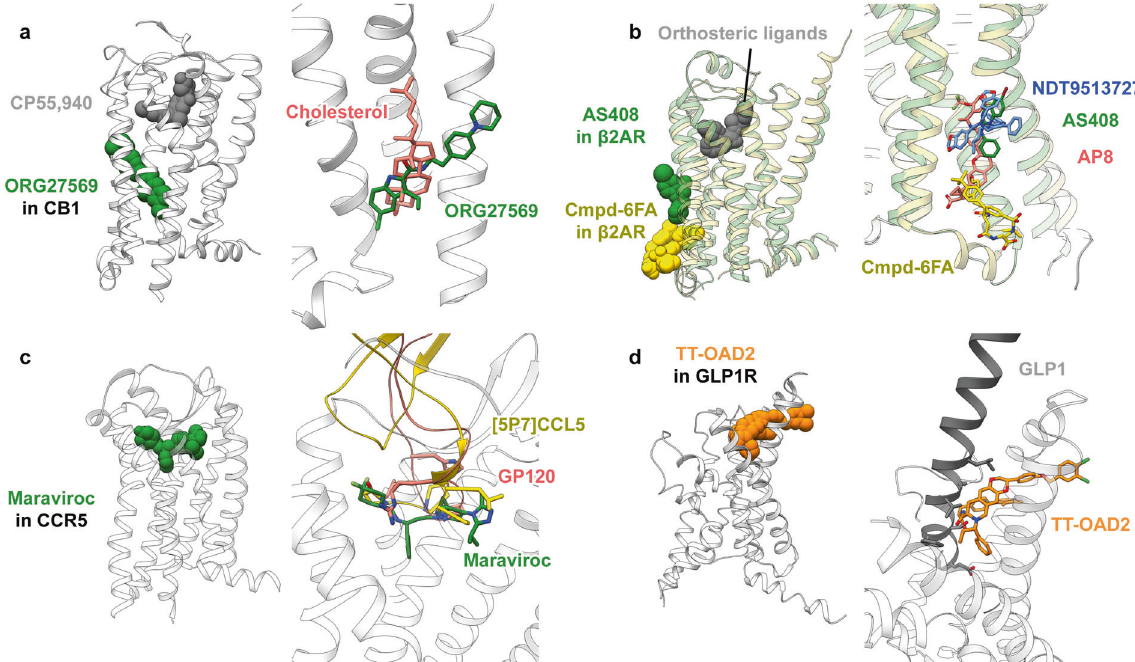
Fig. 10 Binding sites of allosteric modulators in GPCRs reported after October 2018, in comparison with related ligands. a NAM ORG27569 in CB1 (PDB code: 6KQI 166 ) in comparison with cholesterol (PDB code: 5XRA 179 ); b NAM AS408 (PDB code: 6OBA 180 ) and PAM Cmpd-6FA (PDB code: 6N48 181 ) in β 2 AR, in comparison with NDT9513727 in C5AR1 (PDB code: 6C1Q 182 ) and PAM AP8 (PDB code: 5TZY 183 ); c NAM maraviroc in CCR5 (PDB code: 4MBS 187 ) in comparison with chemokine analog antagonist [5P7]CCL5 (PDB code: 5UIW 188 ) and HIV envelope glycoprotein gp120 (PDB code: 6MEO 189 ); d PAM TT-OAD2 in GLP-1R (PDB code: 6ORV 190 ) in comparison with GLP-1 (PDB code: 5VAI 191 ) because partially overlapped sites with different key interactions The cytoplasmic interface, where a GPCR interacts with are also allowed. intracellular partners, including G α and β -arrestin, contains The last case of allosteric modulator in extracellular pocket is pockets suitable for drug design. So far, four small molecules PAM TT-OAD2 of GLP-1R (PDB code: 6ORV 190 ). This small molecule have been validated by crystallography to bind at this position. The targets are three chemokine receptors (CCR2, PDB code: agonist only slightly collides with the endogenous peptide (PDB 5T1A 192 ; CCR7, PDB code: 6QZH 193 ; and CCR9, PDB code: 5LWE 194 ) code: 5VAI 191 , Fig. 10d), consistent with its behavior that only partially displaces an orthosteric probe. 190 and β 2 AR (PDB code: 5X7D 195 ). These ligands are all NAMs and Signal Transduction and Targeted Therapy (2021)